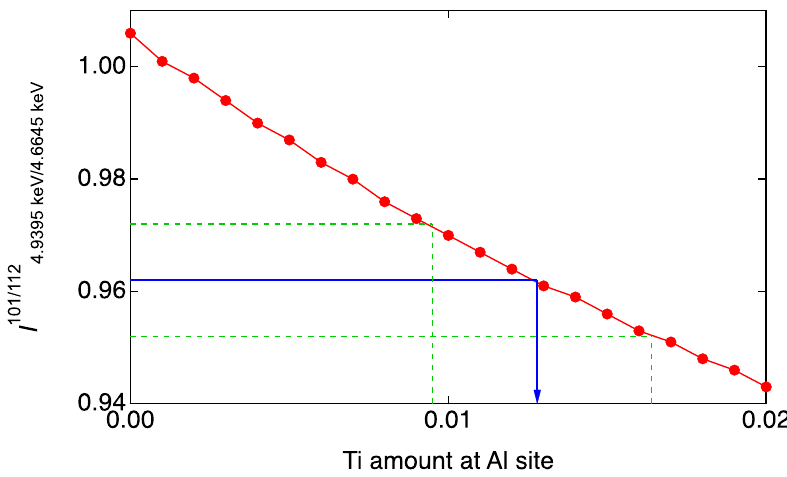
Figure 4. Relationship between the relative intensity and the amount of Ti substituted at Al sites. The solid bule line represents the Ti amount at the Al site in NaAlH 4 with statistical error (dotted green lines).